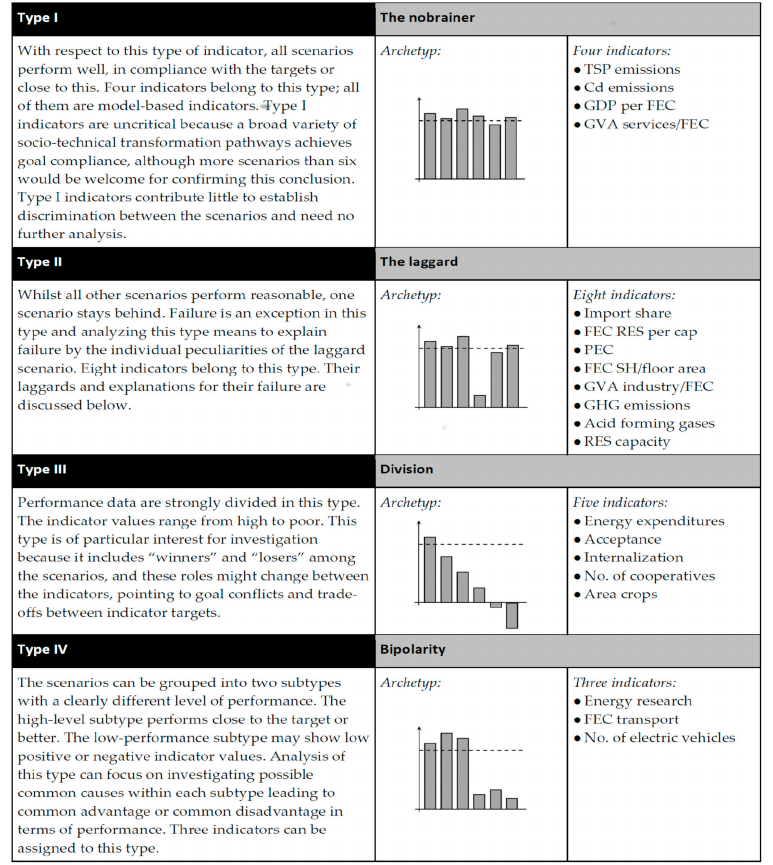
Figure 6. Overview of the four archetypes of indicator profiles.